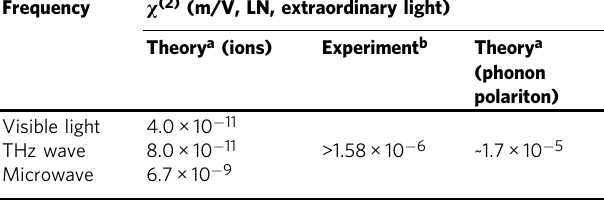
Experimental values for visible light and microwave are quoted from 36